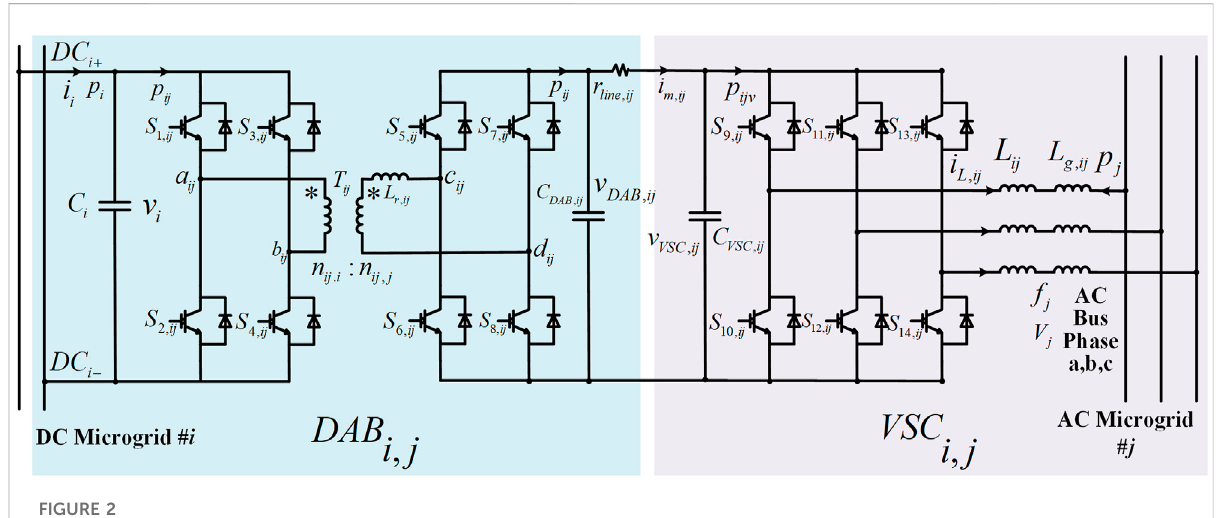
FIGURE 2 Typical topology structure of the uni fi ed interface IIC i ,